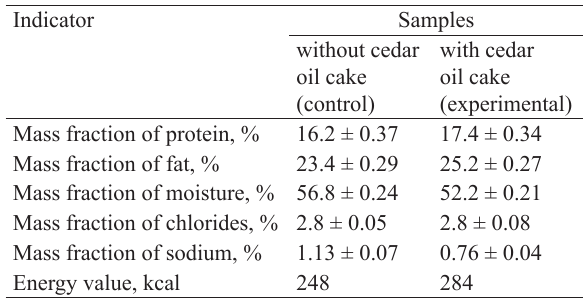
Table 6 Physicochemical characteristics the semi-smoked sausages Indicator Samples without cedar